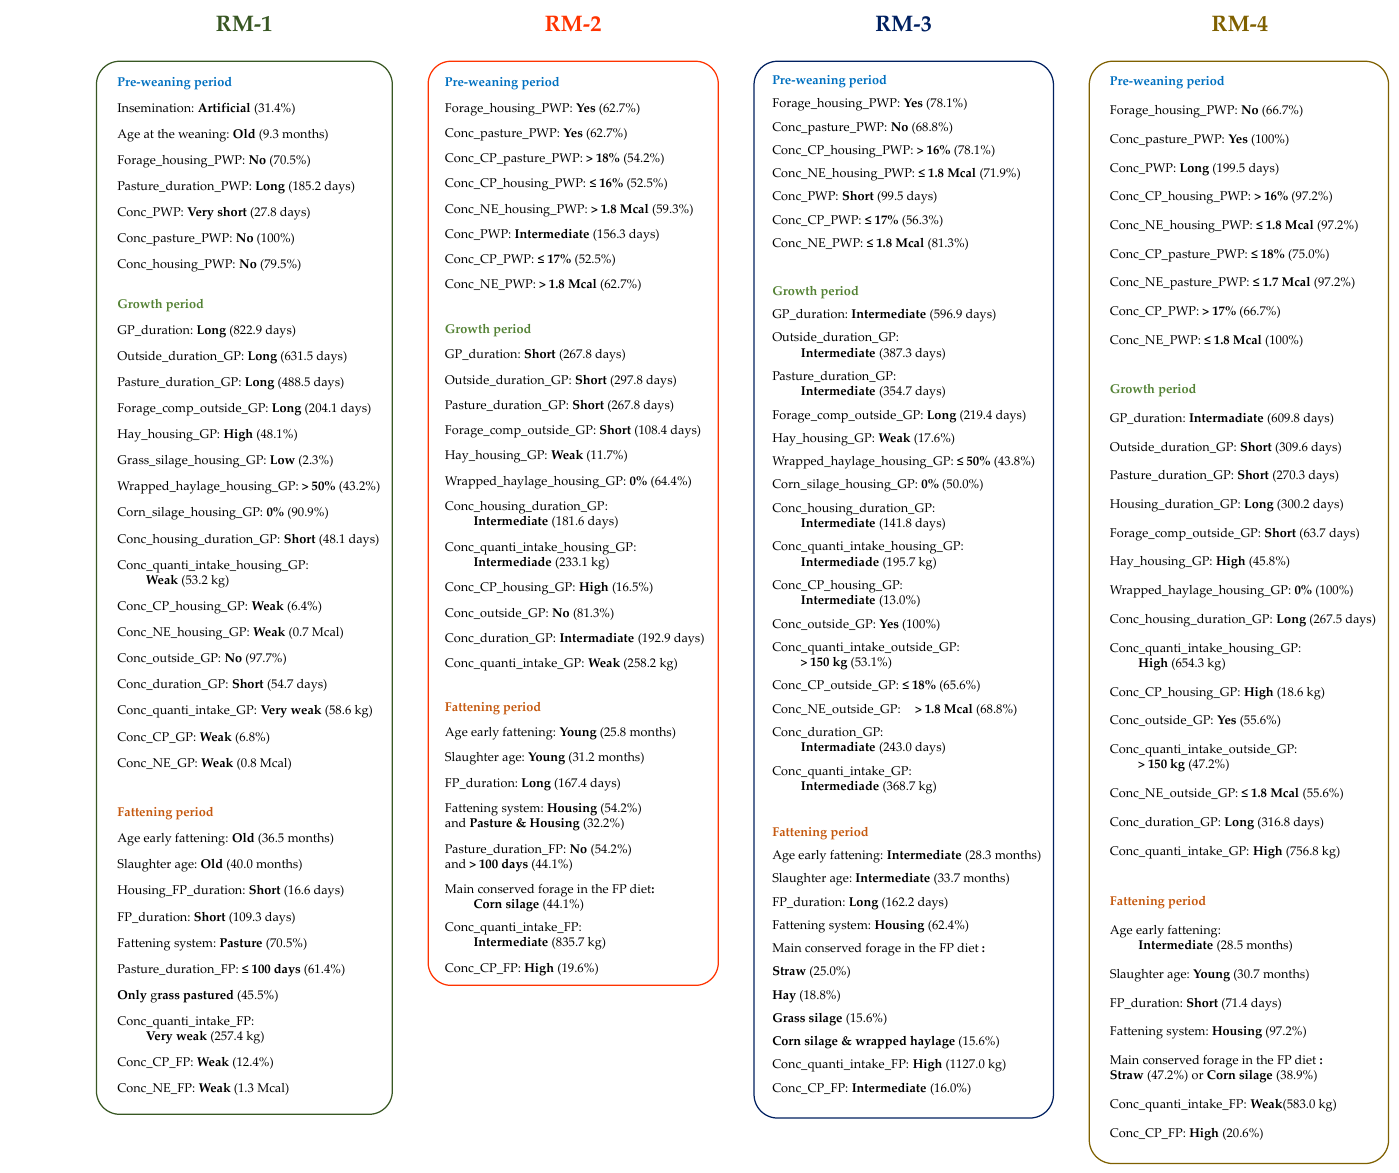
Figure 2. Summary of the four rearing managements (RM) applied during the whole life of the heifers. PWP: Pre-weaning period, GP: Growth period, FP: Fattening period, Conc_CP: Calculated average of concentrate’s crude protein, Conc_NE: Calculated average of concentrate’s net energy, Conc: Concentrate, Conc_quanti_intake: Total concentrate quantity intake per heifer, Forage_comp: Number of days when forages were offered outside, Main forage: Main forage in the fattening diet.